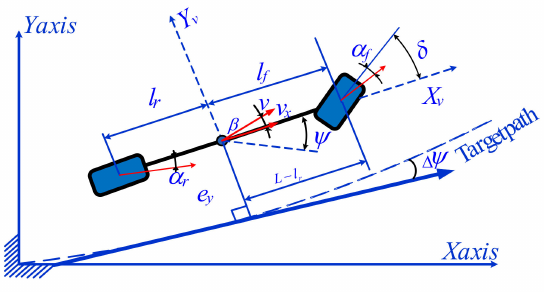
Figure 2. DOF vehicle dynamics